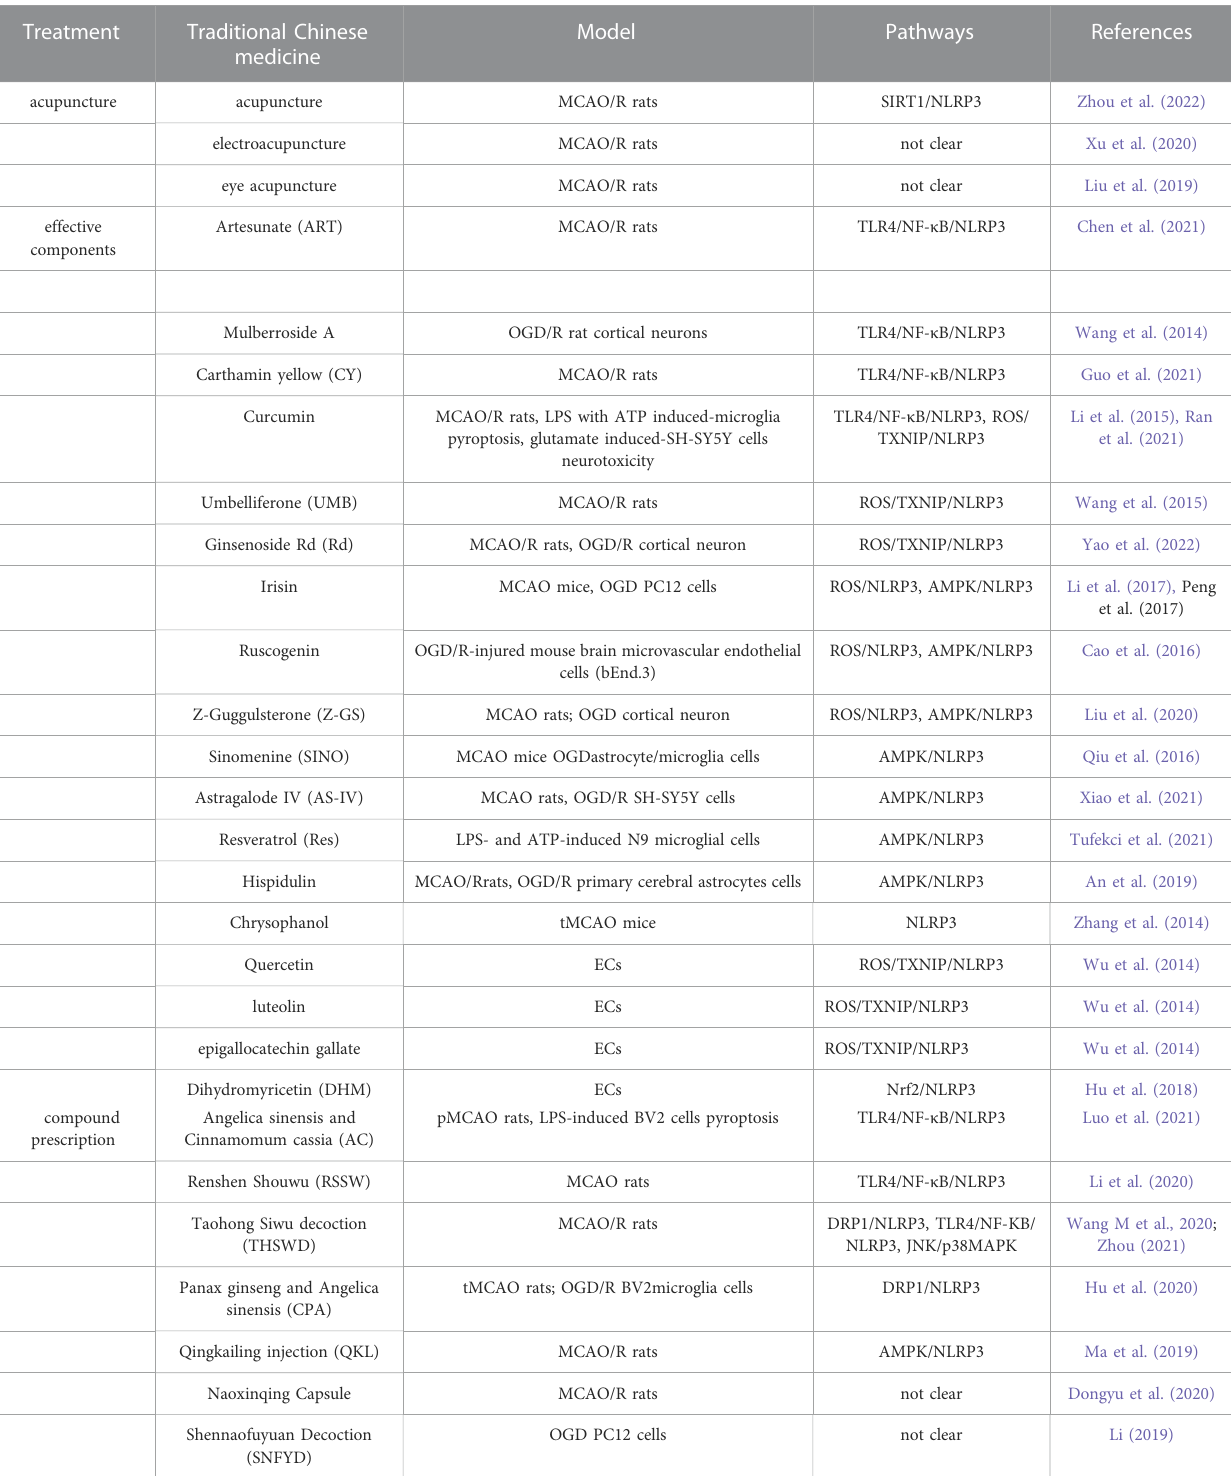
TABLE 1 Advance in treatment of traditional Chinese medicine against IS by drug intervention